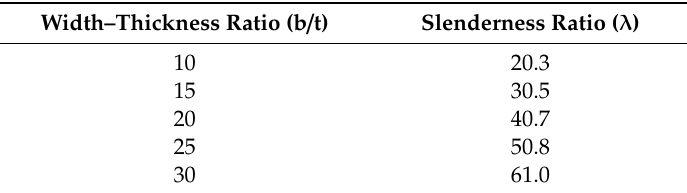
Table 7. Slenderness ratio of equal stability